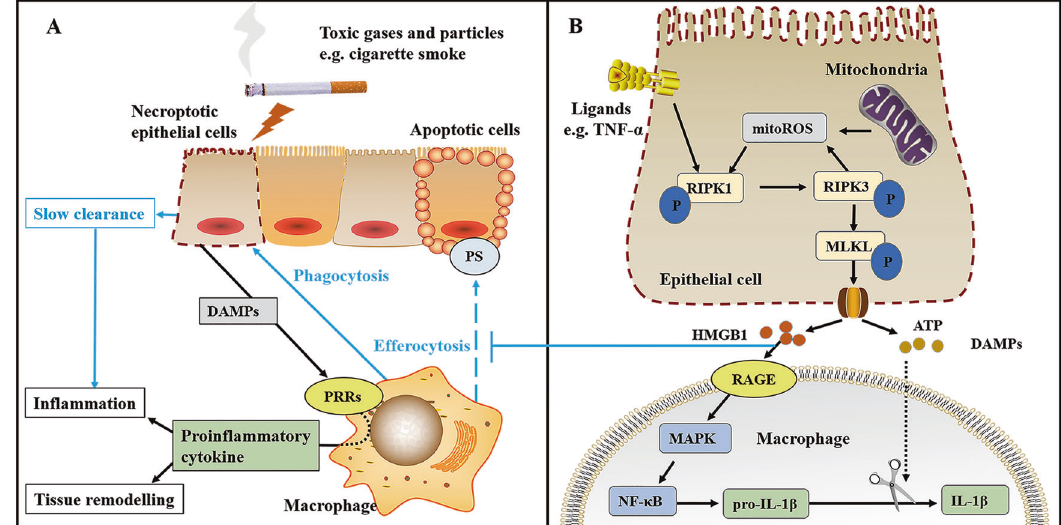
Fig. 3 The mechanism of necroptosis leads to air fl ow limitation in COPD. A Lung parenchymal epithelial cells undergo necroptosis due to direct exposure to toxic gases and particles (e.g. cigarette smoke). Excessive DAMPs are released and linked to PRRs on neighbouring macrophages after plasma membrane rupture, leading to pro-in fl ammatory cytokine production through multiple pathways and consequently causing in fl ammation and tissue remodelling in the lung parenchyma. In addition, the impaired ability of macrophages to phagocytose apoptotic epithelial cells in COPD and the slower clearance of necroptosis cells by macrophages can cause inadequate phagocytosis of dead cells, which triggers in fl ammation. B Epithelial cell membrane receptors bind to the corresponding ligands (e.g. TNF- α ) and send signals to cause RIPK1 activation, followed by RIPK3 recruitment and phosphorylation. Mitochondrial ROS contributes to RIPK1 autophosphorylation, but the production is dependent on RIPK3. RIPK3 can also mediate MLKL phosphorylation, causing